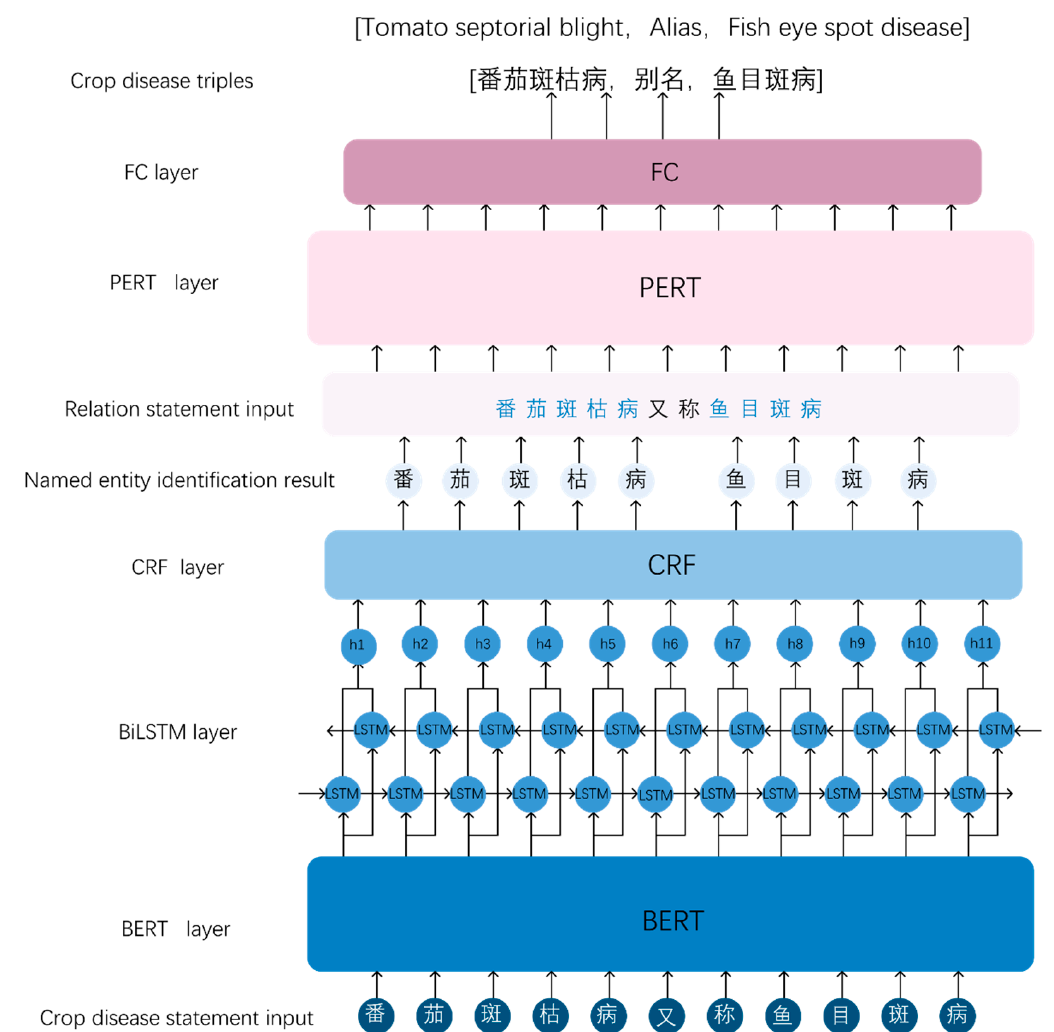
Figure 1. Triple-extraction model. Example “ 番茄斑枯病又称鱼目斑病 ” (this means that tomato septorial blight is also known as fish eye spot disease).